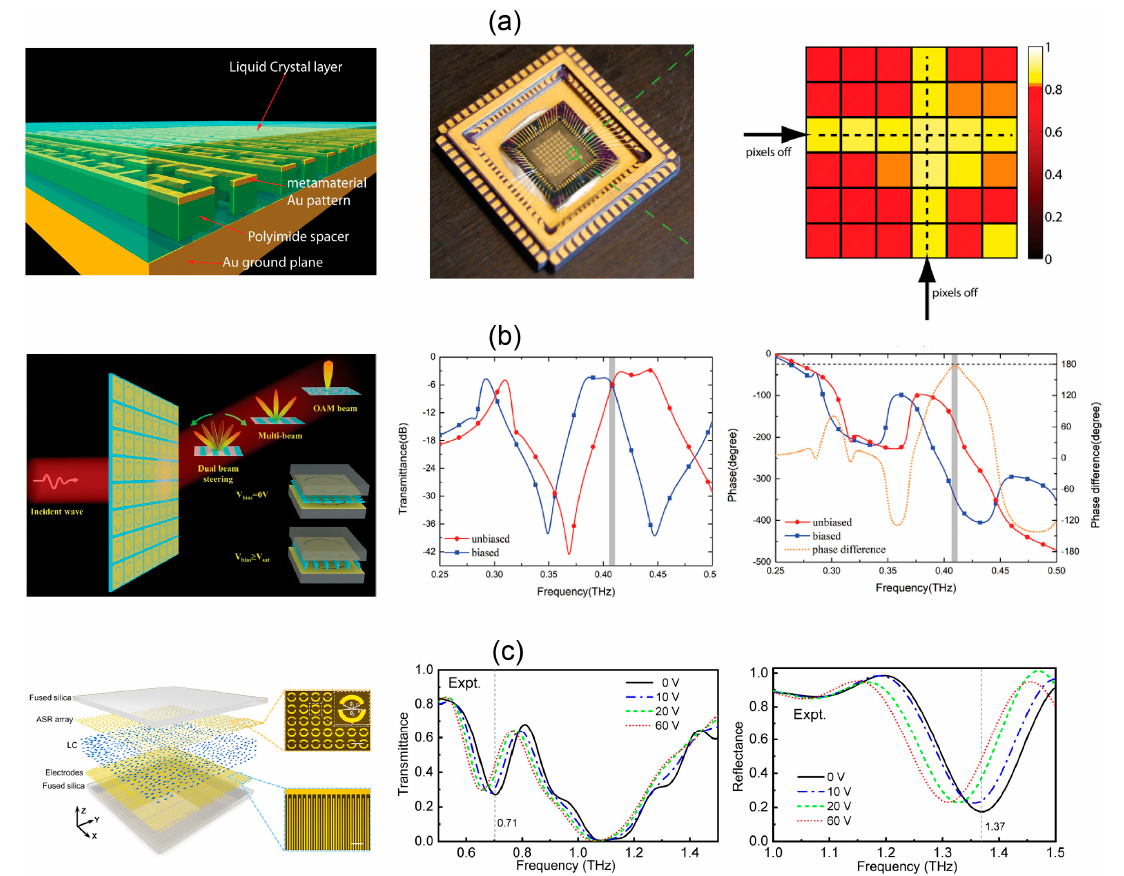
Figure 3. THz metasurface SLMs based on liquid crystals. ( a ) Reflective LC SLM based on a THz metasurface absorber, the packaged sample and a spatial absorption pattern. Reproduced with permission from [51]. Copyright 2014 John Wiley & Sons, Inc. (Hoboken, NJ, USA) ( b ) Transmissive LC − metasurface SLM and its binary phase modulation. Reproduced with permission from [53].